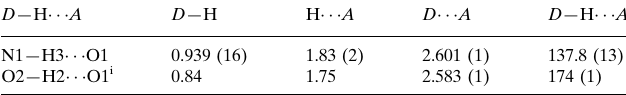
Hydrogen-bond geometry (A˚ , (cid:1)